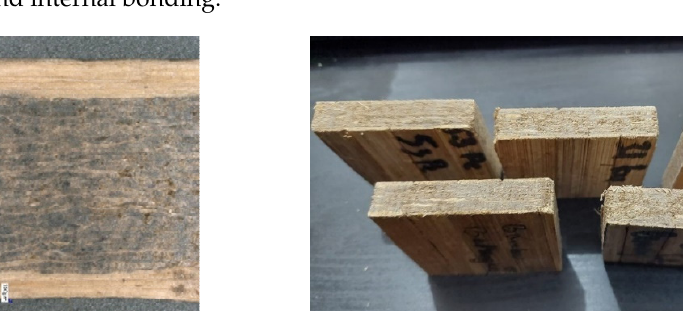
Figure 1. Sample arrangement. Table 1. Particleboard raw material requirements.